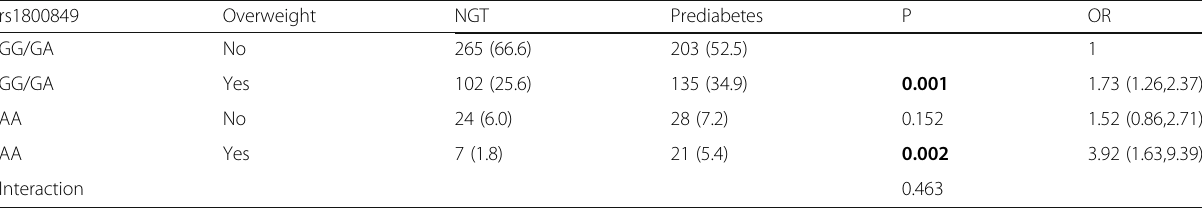
Table 4 Interaction analysis for rs1800849 and overweight on prediabetes rs1800849